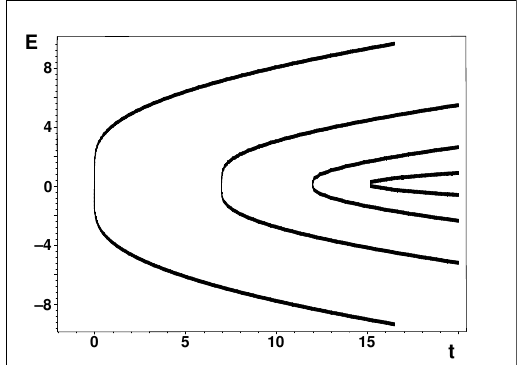
Figure 1. The numerically calculated unfoldings and smoothness of the real eigenvalues of our toy model H ( 8 ) ( t )